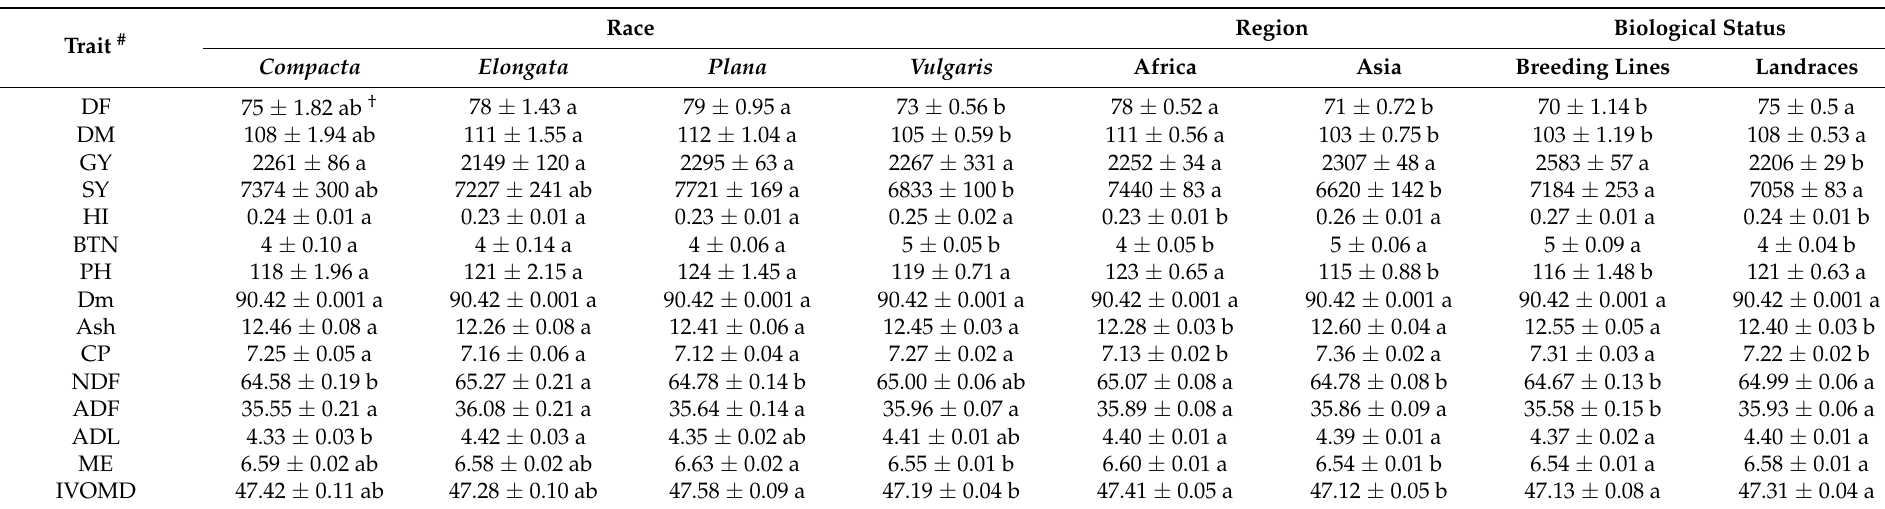
Table 3. Mean comparison on races, region, and biological status of 314 finger millet accessions on agronomic and forage quality traits. Trait